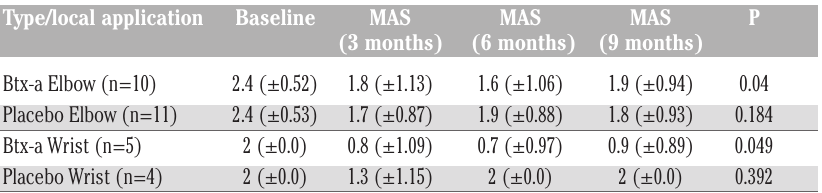
Table 2. Mean and standard deviation of the measurement of Modified Ashworth Scale (MAS) during the treatment period with btx-a and